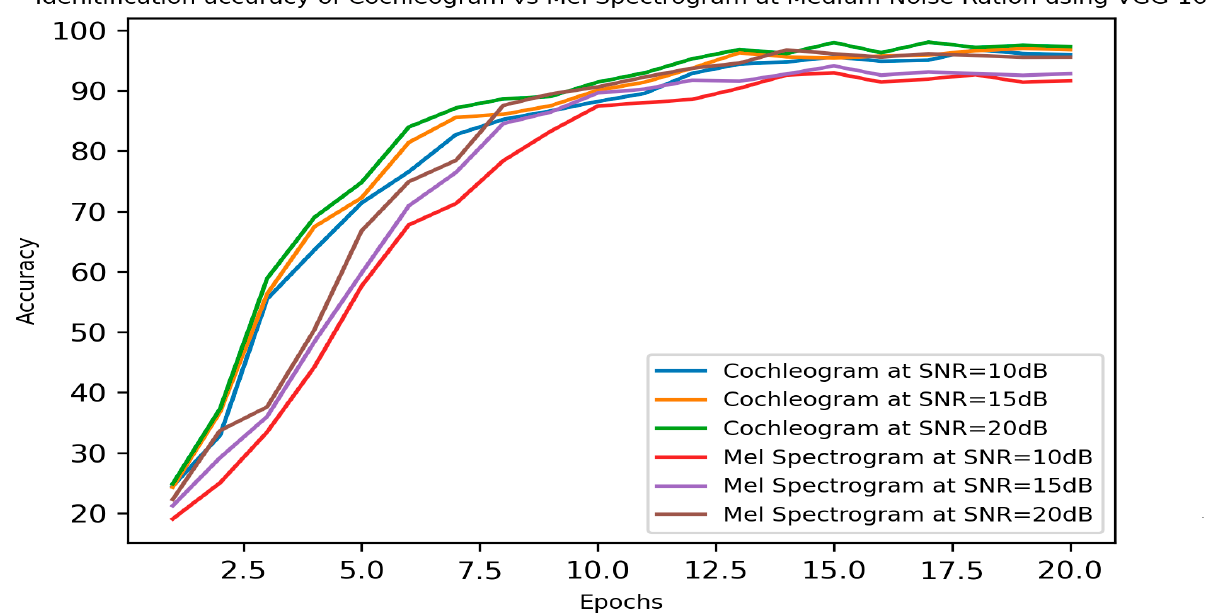
Figure 6. Speaker identification Accuracy of Cochleogram and Mel Spectrogram at Low Noise Ratio (Without Additive Noise) using VGG-16 Architecture.